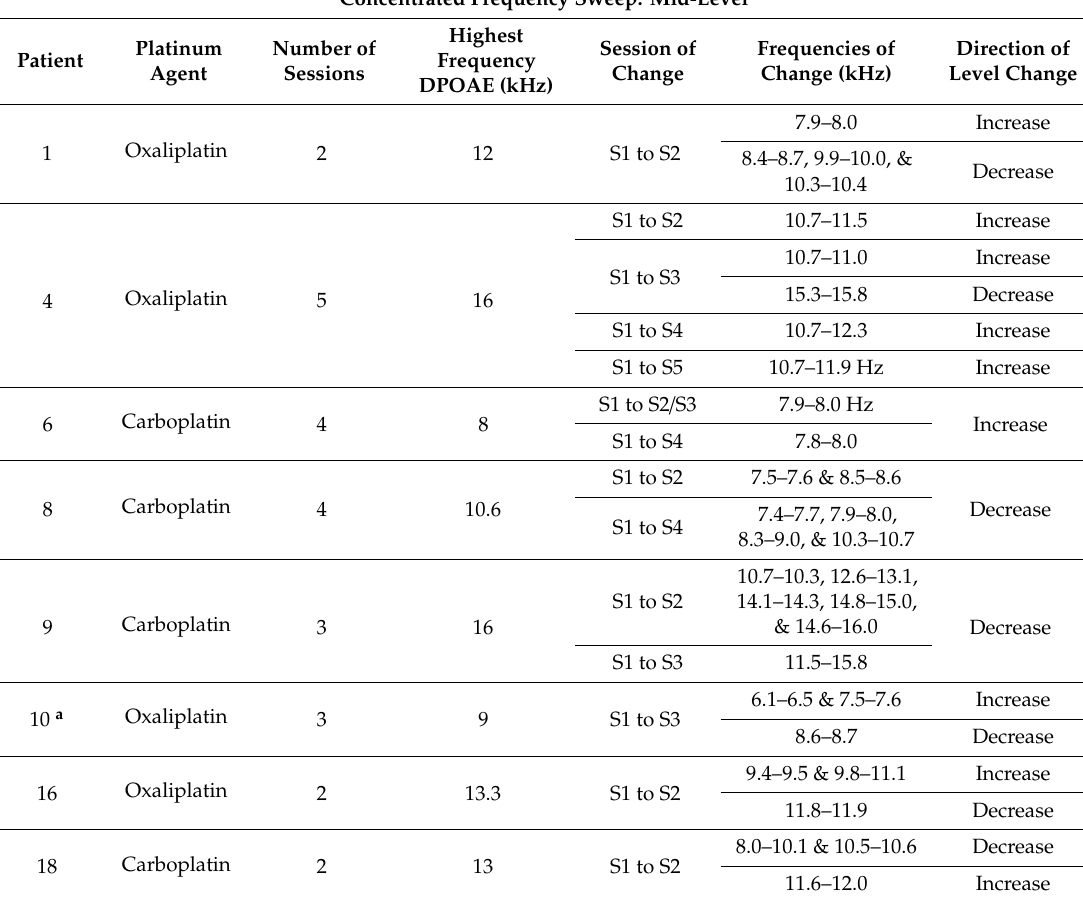
Table 2. Patient number, platinum agent received, total number of mid-level concentrated frequency sweep sessions performed, sessions (S) where changes occurred, frequency and direction of DPOAE level changes compared to